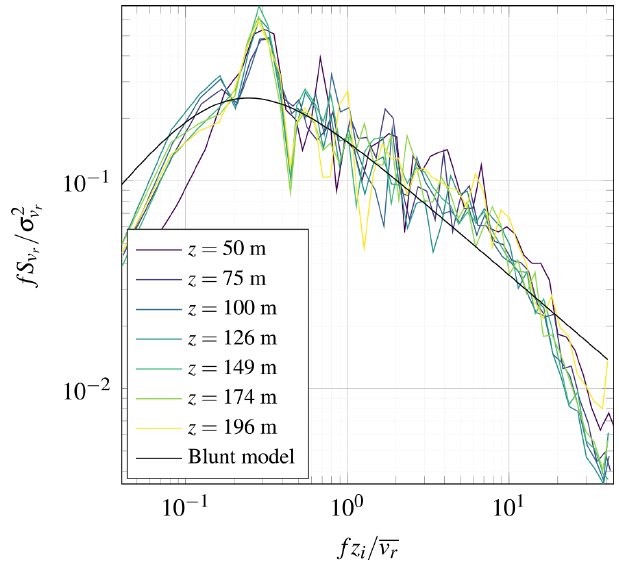
Figure 19. Power spectral density estimate of the velocity compo- nent v r recorded on 25 October 2019 from 13:35 to 14:25 using beams parallel to the mean wind direction with an elevation angle of 4 . 9 ◦ . The mean wind speed was v r ≈ 14ms − 1 at the different heights selected and z i =